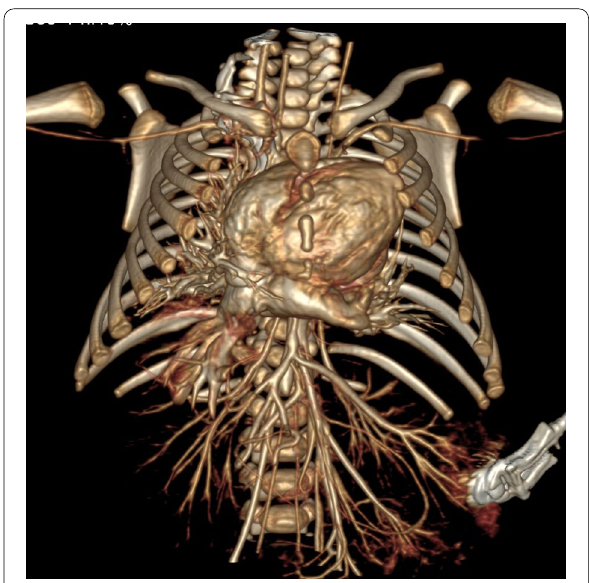
Fig. 10 3D volume rendering image showing Topsy Turvy heart with the cardiac apex in the left infraclavicular